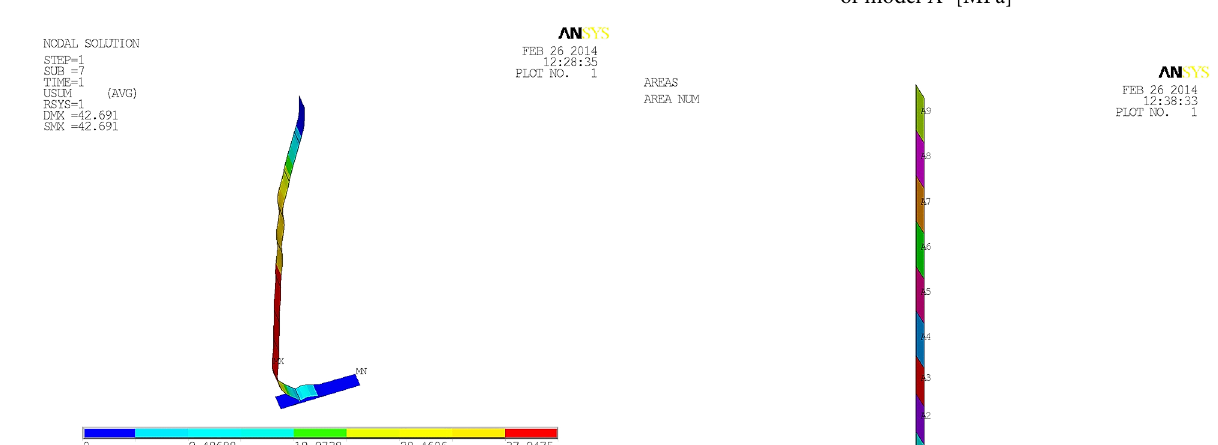
Fig. 6. Membrane reduced stress acc. to von